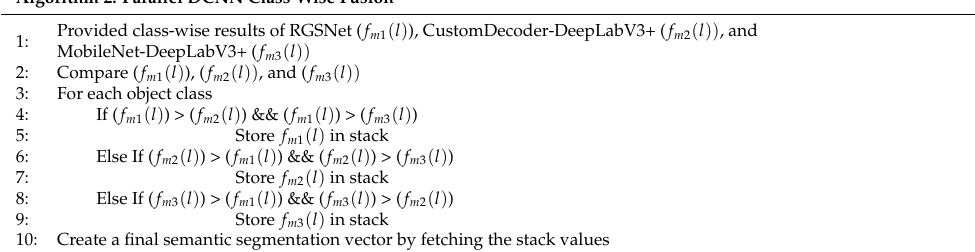
Algorithm 2: Parallel DCNN Class-Wise